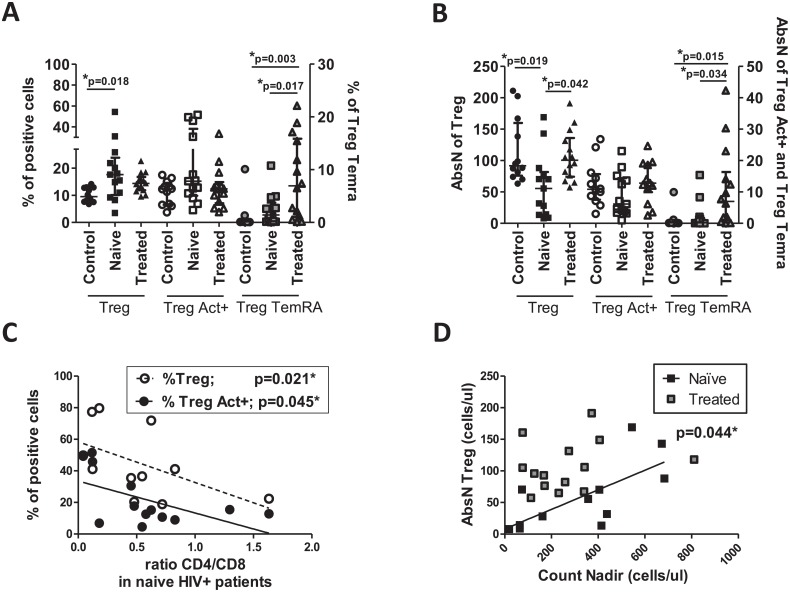
Alteration of Treg compartments in HIV+ and healthy individuals.(A) Frequencies and (B) absolute numbers (AbsN) of Treg, activated Treg (Treg Act+: CD25+CD127negHLA-DR+CD45RO+) and Treg TemRA (CD25+CD127negCD27negCD45RA+) were determined in whole blood using cell surface labeling. Frequencies of total Treg were obtained relative to CD4+ T cells and frequencies of Treg subsets were obtained relative to CD25+CD127neg. (C) Correlation between frequencies of total Treg or Treg Act+ and the ratio CD4/CD8 in HIV+ treatment-naïve individuals. (D) Correlation between absolute counts of Treg (AbsN Treg) and nadir count (black squares: HIV+ treatment-naïve individuals and grey squares: treated-HIV+ individuals). Medians ± IQRs are represented. Correlations were determined by Spearman’s rank correlation. Control: Healthy individuals. Naïve: HIV+ treatment-naïve individuals. Treated: Treated-HIV+ individuals. * = p<0.05 when comparing conditions. Each symbol corresponds to an individual.